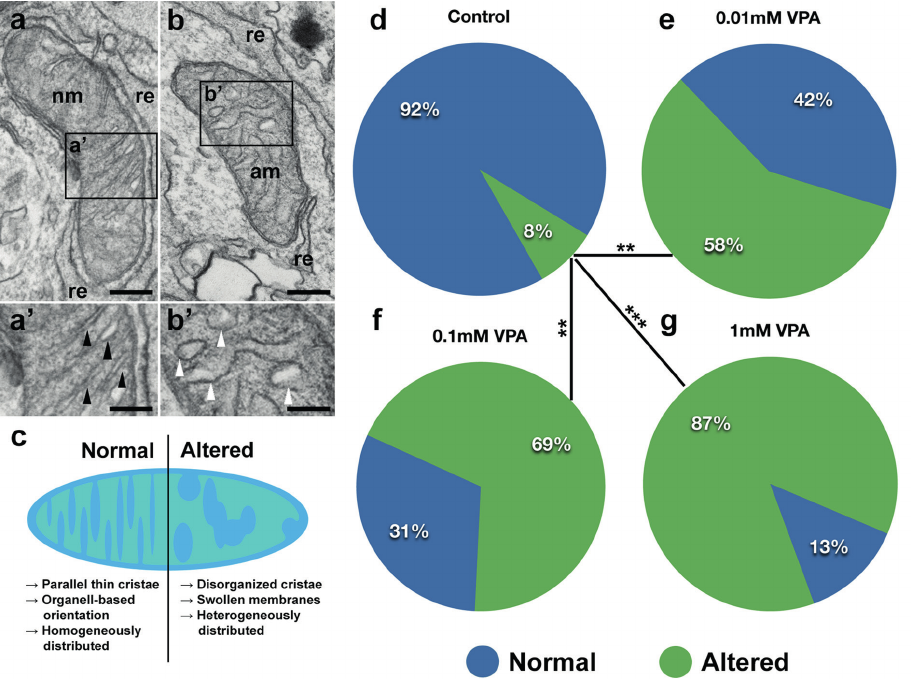
Figure 2 - VPA increases the number of altered mitochondria. Normal mitochondria (nm) presented regular distribution of cristae ( a and a’ ) (black arrowheads) whereas altered mitochondria (am) presented disorganized and heterogeneous distribution of cristae ( b and b’ ) (white arrowheads). Endoplasmic reticulum (er) was observed in close contact with mitochondria in all conditions. Graphic representation of mitochondria depicts morphological features used in classification ( c ). Control cells presented 8% ± 2% of altered mitochondria ( d ). VPA treatment showed significant increase in 0.01mM (58% ± 3%) ( e ), 0.1mM (69% ± 11%) ( f ) and 1mM (87% ± 8%) ( g ) concentrations. Bar in a and b = 500nm; bar in a’ and b’ = 250 nm. **p<0.01 and ***p<0.001